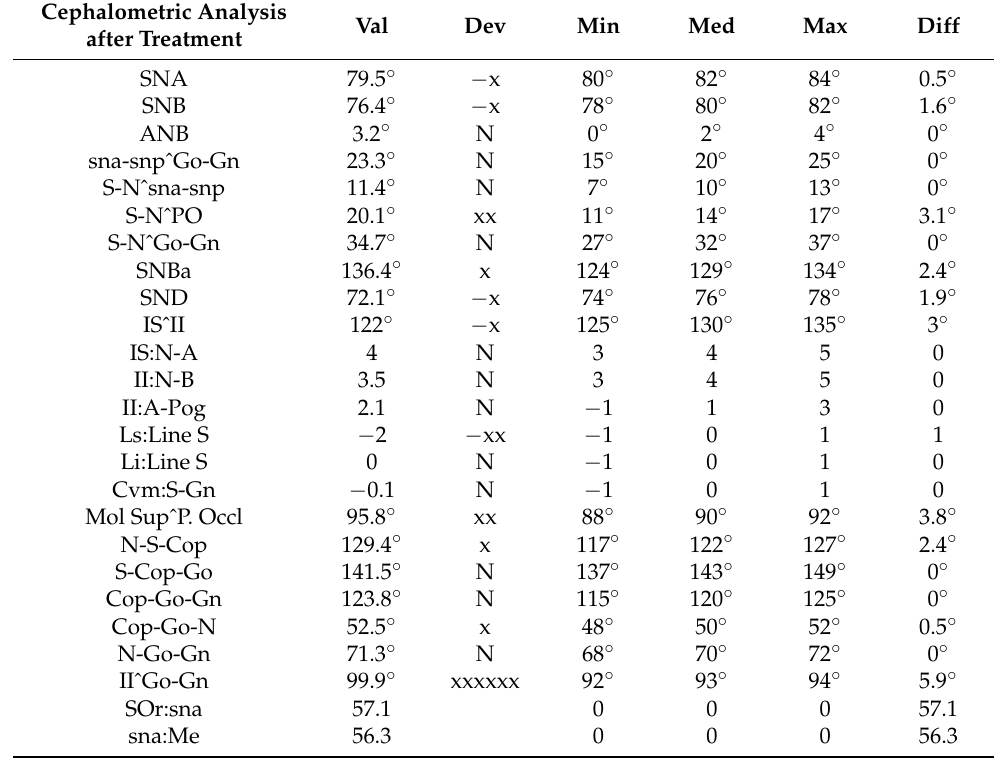
Figure 29. Cephalometric tracing (DeltaDent software) after treatment (9-year-old). Table 6. Cephalometric analysis after treatment.